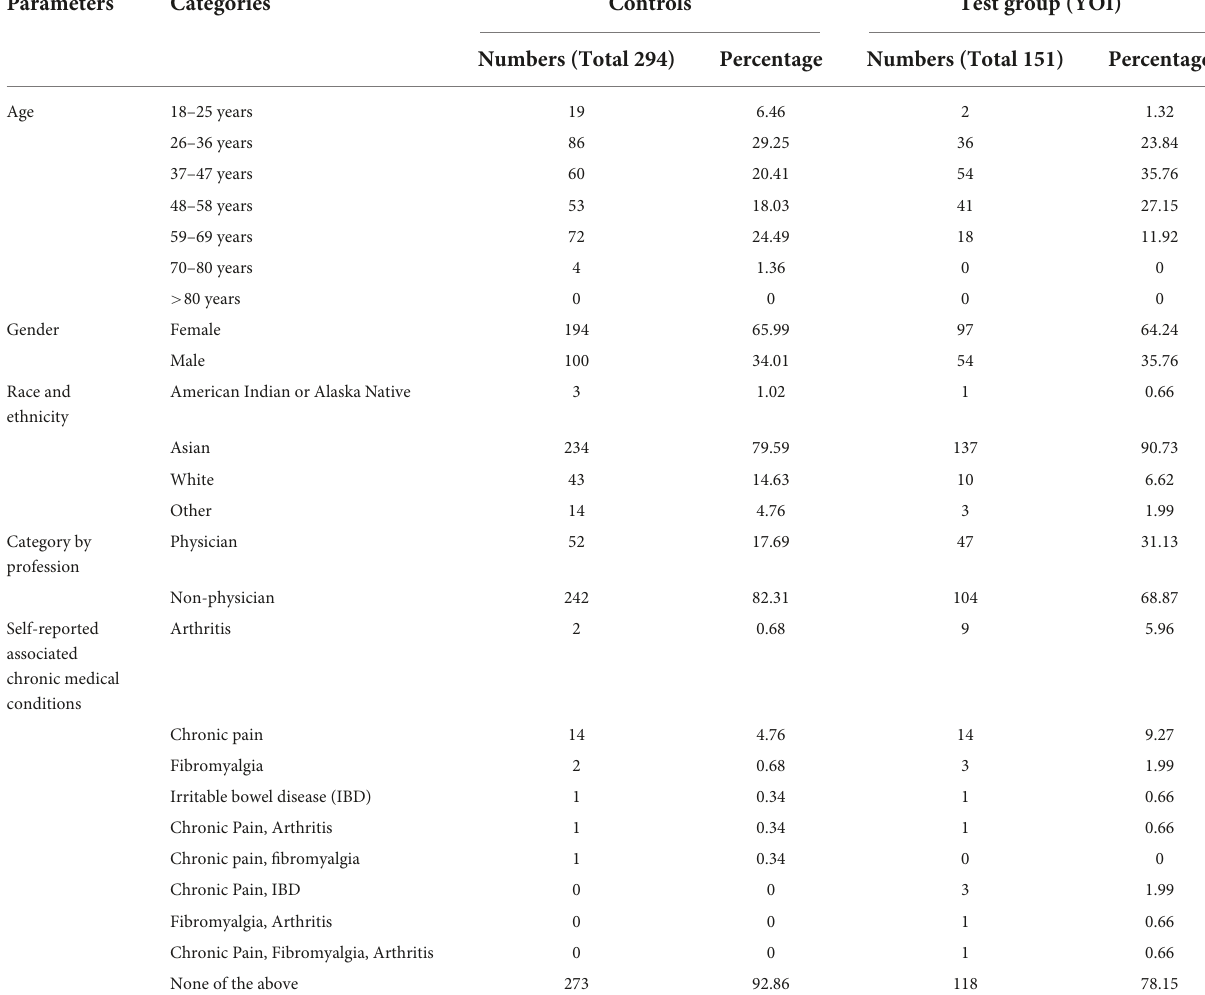
TABLE 1 Demographic details of the study population in numbers as well as